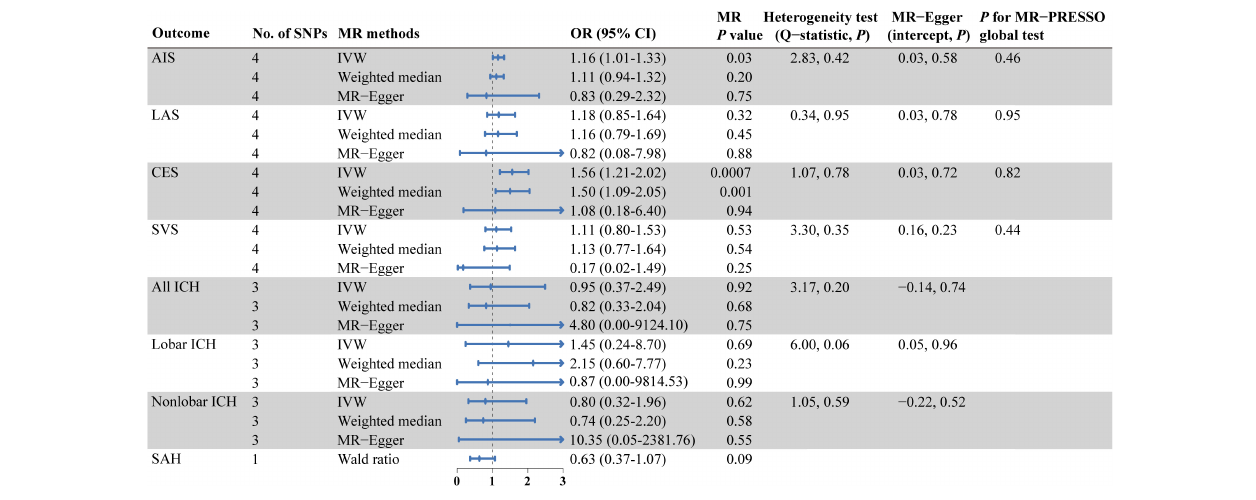
FIGURE2 MR estimates from each method of assessing the causal effects of isoleucine level on the risk of stroke and its subtypes. AIS, any ischemic stroke; LAS, large artery stroke; CES, cardioembolic stroke; SVS, small vessel stroke; ICH, intracerebral hemorrhage; SAH, subarachnoid hemorrhage; SNPs, single nucleotide polymorphisms; MR, Mendelian randomization; IVW, inverse variance weighted; OR, odd ratio; CI, confidence interval; MR-PRESSO, MR pleiotropy residual sum and outlier.